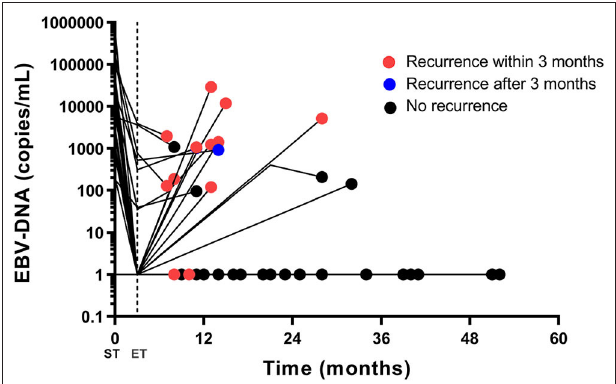
FIGURE 3 | The EBV-DNA trajectory for the 41 patients having pre-treatment, post-treatment, and follow-up results. Pre-treatment, post-treatment and at least one follow-up EBV-DNA (first increase and first increasing EBV-DNA level exceeding 1,000 copies/mL) results are plotted. If an EBV-DNA copy number declines or remains unchanged during follow-up, only the last EBV-DNA copy number is plotted. The red dot stands for radiologic recurrence within 3 months, and the blue dot stands for radiologic recurrence after 3 months. The black dot stands for no radiologic recurrence. Most of the patients with persistent EBV-DNA copy number = 0 are free of recurrence. All patients with an increasing EBV-DNA > 1,000 copies/mL had immediate disease recurrence. EBV, Epstein-Barr virus; DNA, deoxyribonucleic acid; ST, start of treatment; ET, end of treatment.